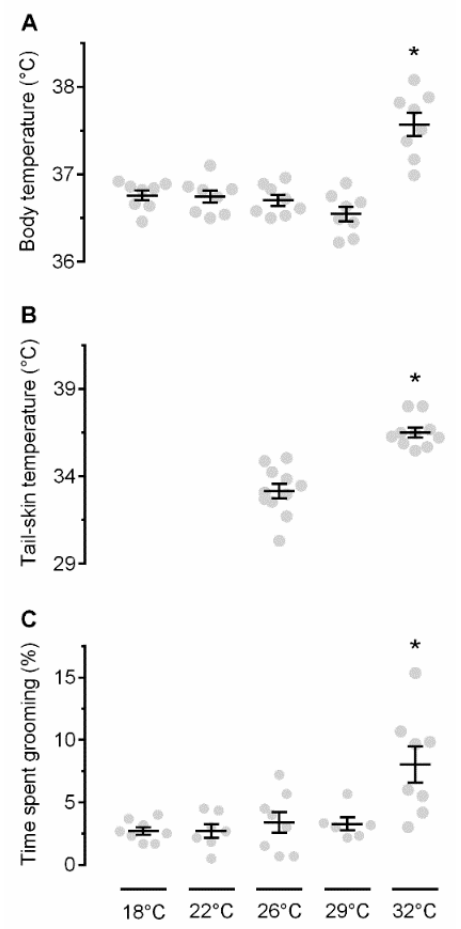
Figure 1. Effects of different T a s on T b ( A ), T sk ( B ), and grooming ( C ). An asterisk (*) indicates a significant difference ( p < 0.05), as compared to the neutral T a (26 °C).